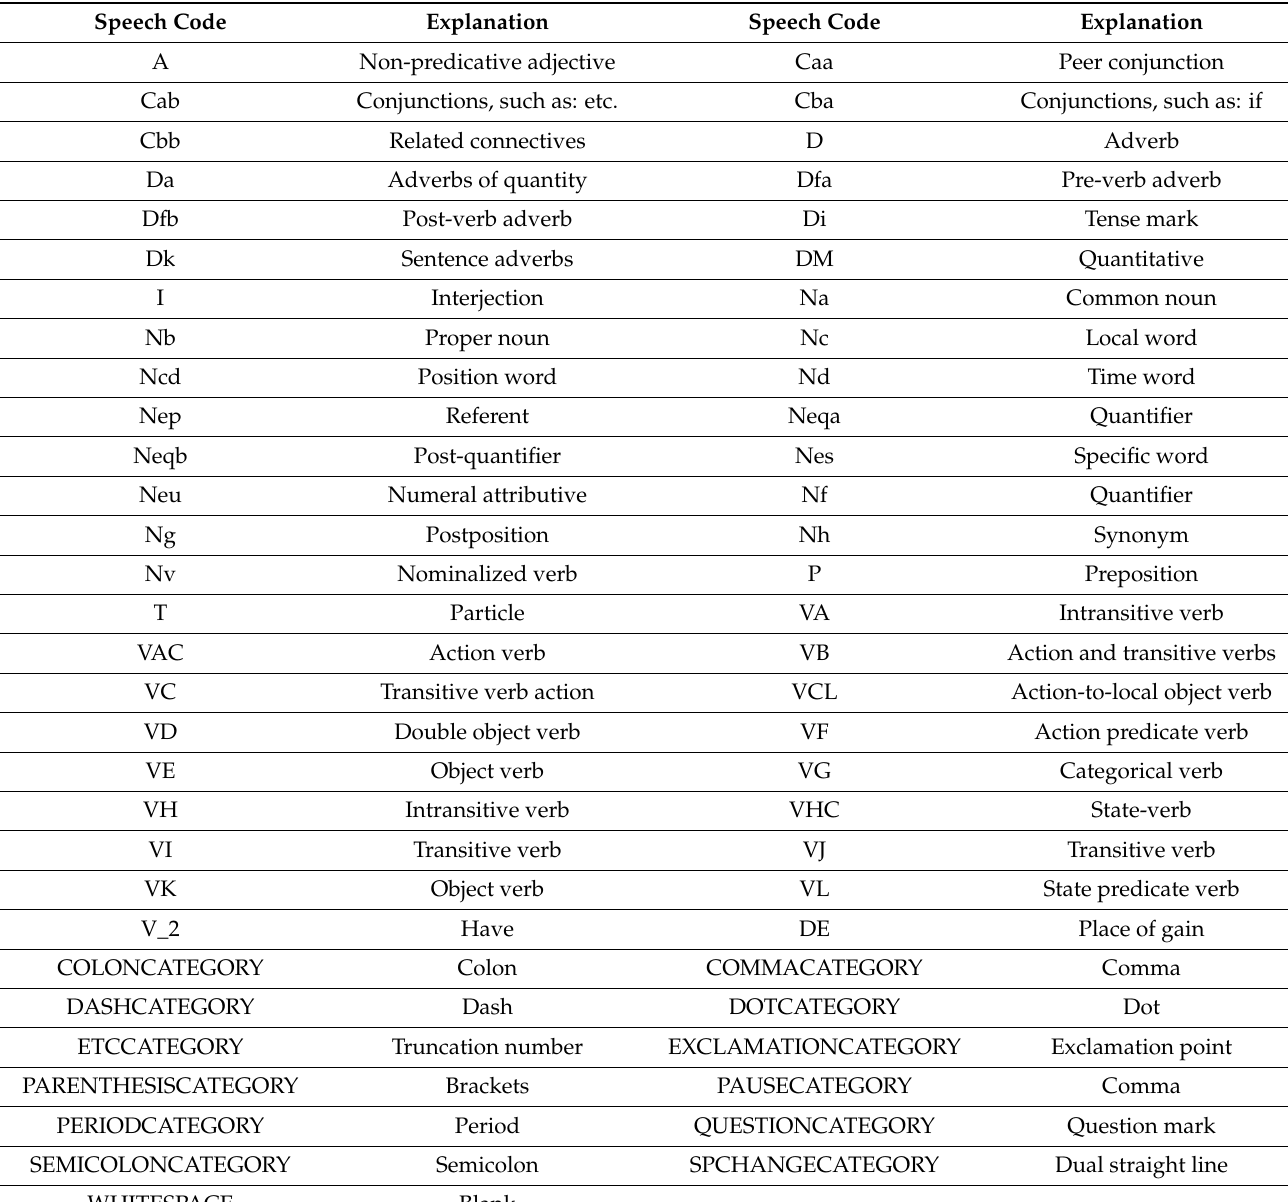
Table 1. English speech